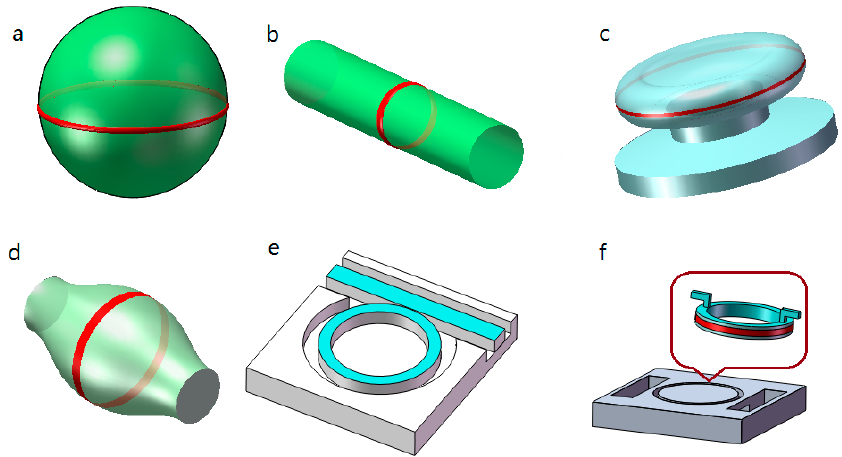
Figure 2. Classical configurations of whispering gallery mode (WGM)-based microcavities. ( a ) Microsphere; ( b ) cylindrical ring; ( c ) microdisk or microtoroid; ( d ) microbottle; ( e ) monolithic solid core microring; ( f ) monolithic liquid core microring.